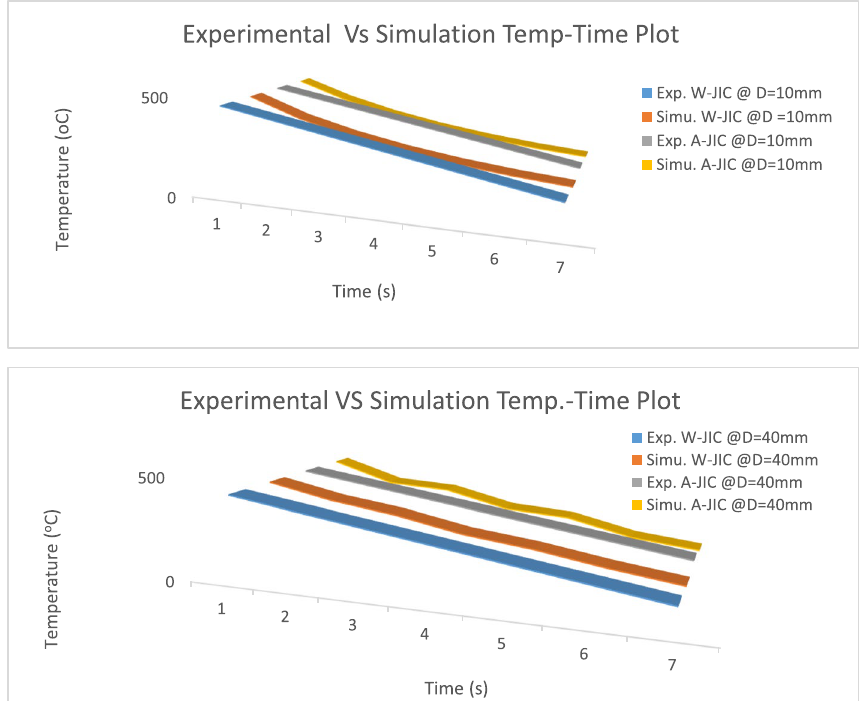
Fig. 18 Experimental and simulation temp-time plot, top for D